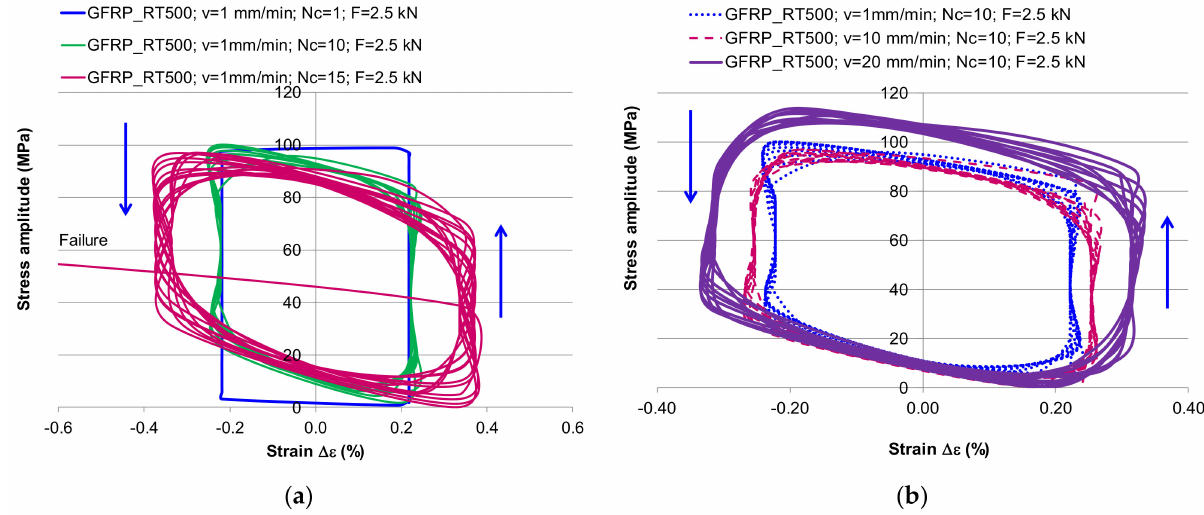
Figure 6. The nonlinear effect of cyclic stresses: ( a ) hysteresis stress–strain curves with increasing the number of cyclic loading; ( b ) hysteresis curves with increasing the loading